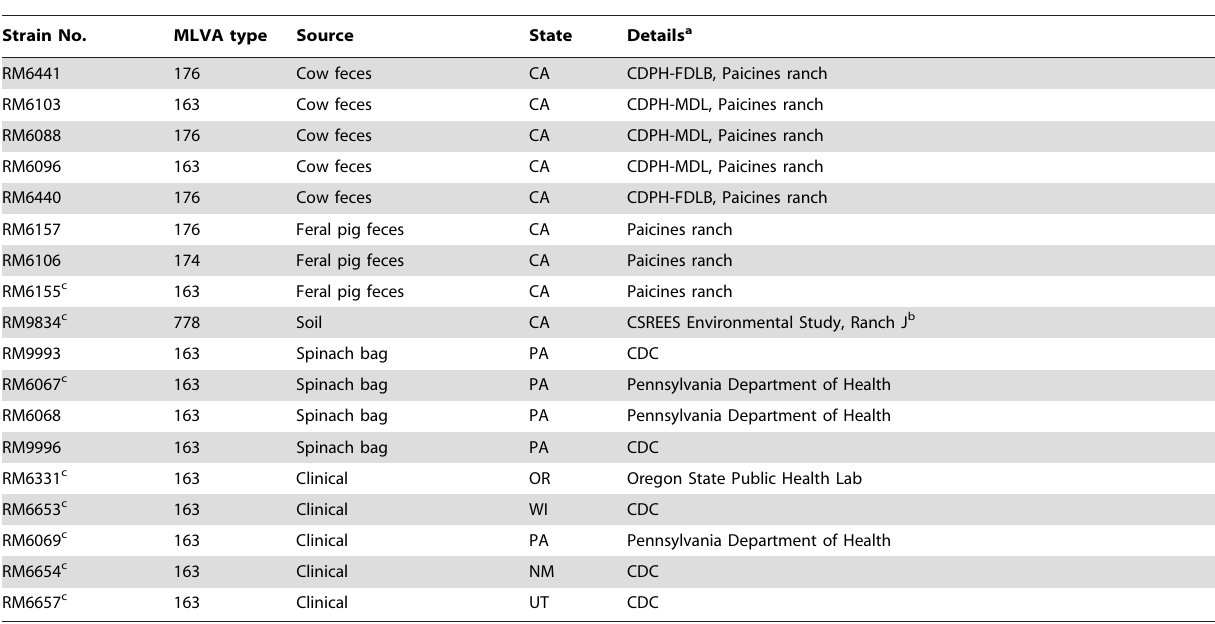
Table 1. EcO157 strains associated with 2006 spinach outbreak.